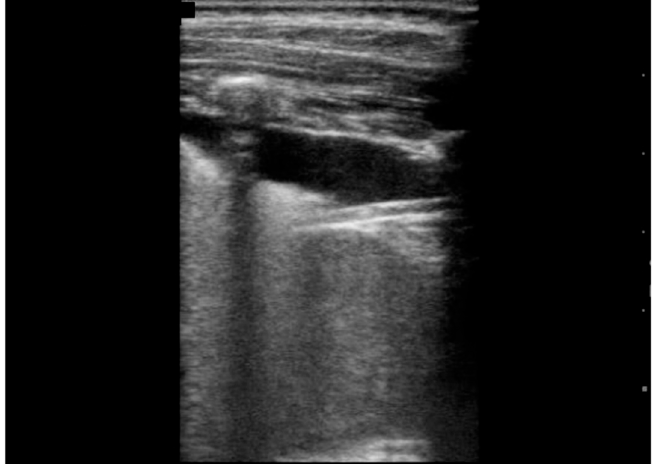
Figure 2. Pleural effusion < 1 cm, white lung.